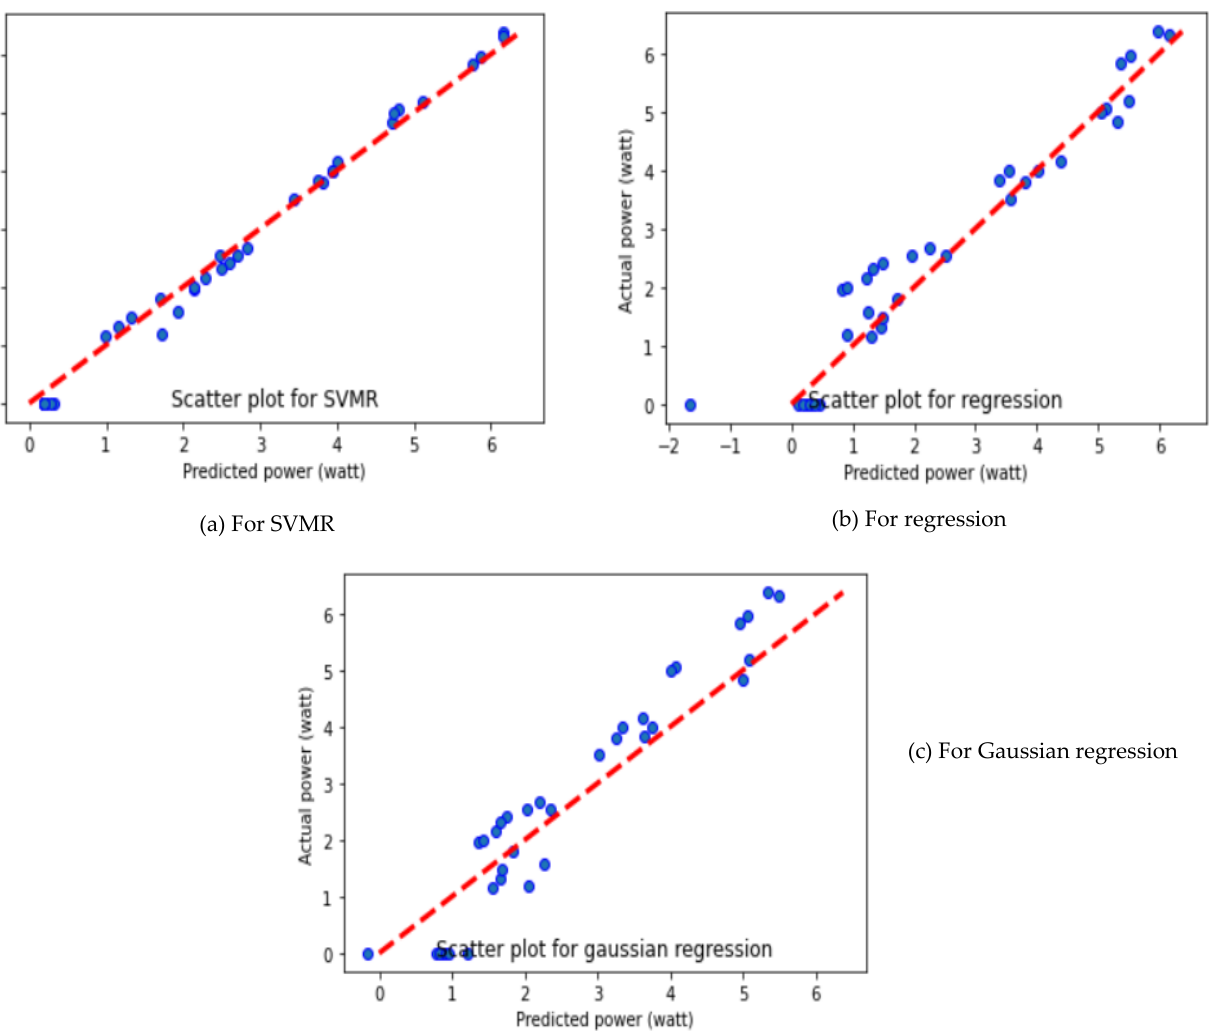
Figure 4. Prediction of output power of solar PV panel using different ML algorithms for Fold-2.